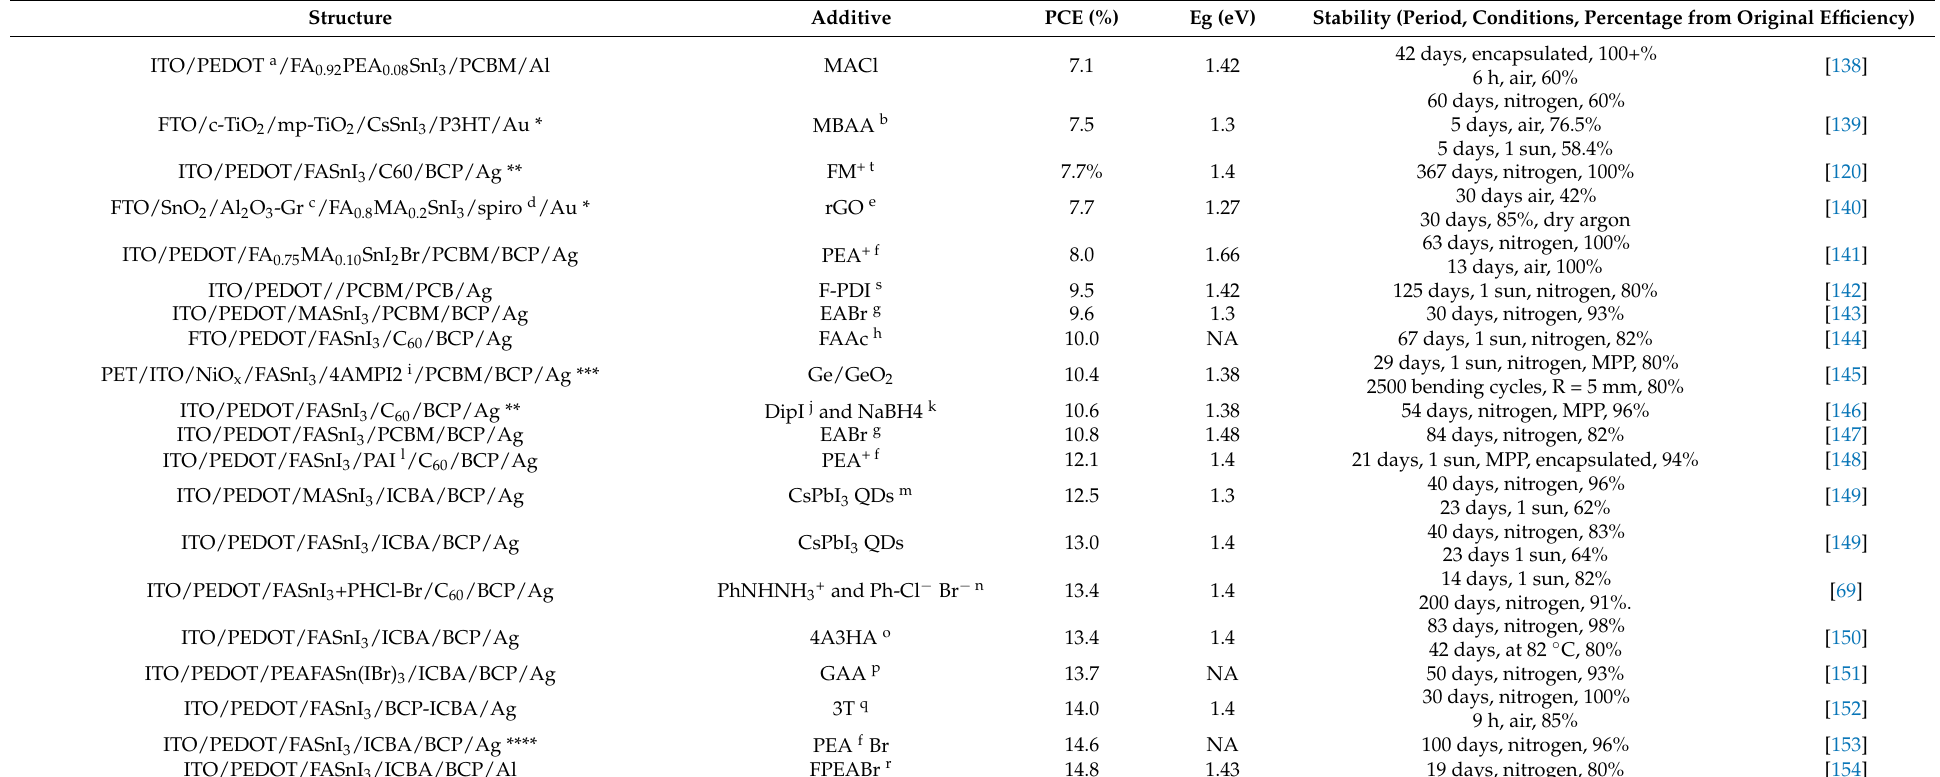
Table 1. Best performing Pb-free TPSCs with perovskite additives reported in 2021 and 2022. Structure